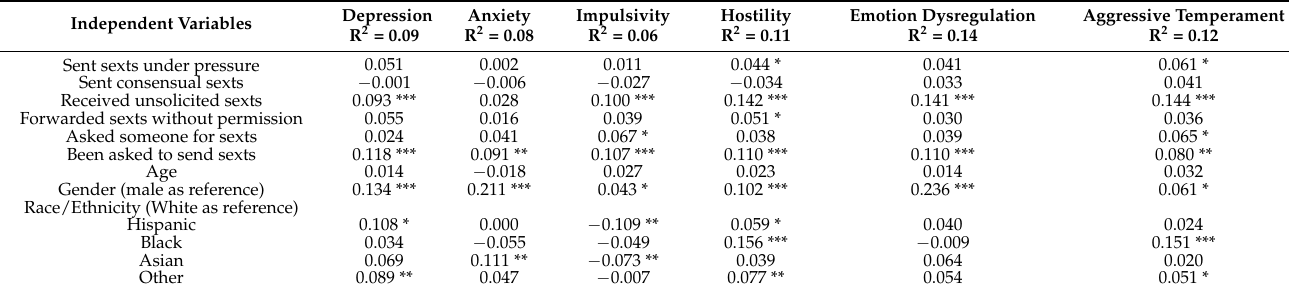
Table 2. Multilevel multivariate regression